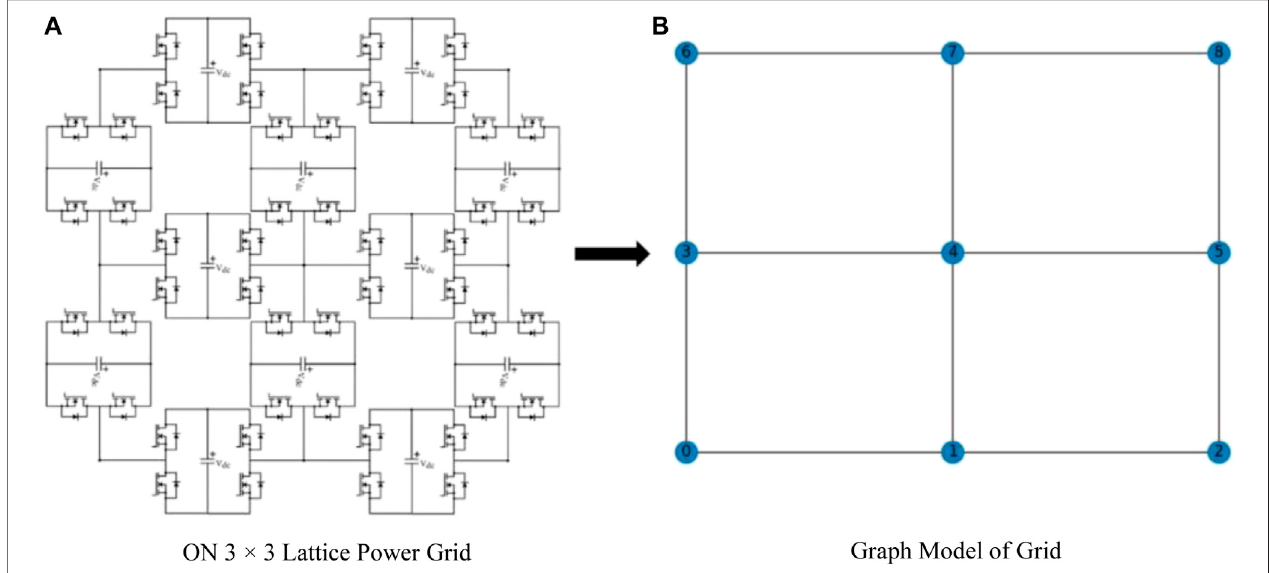
FIGURE 3 | Square lattice grids and its graph model. (A) ON 3 × 3 lattice power grid. (B) Graph model of